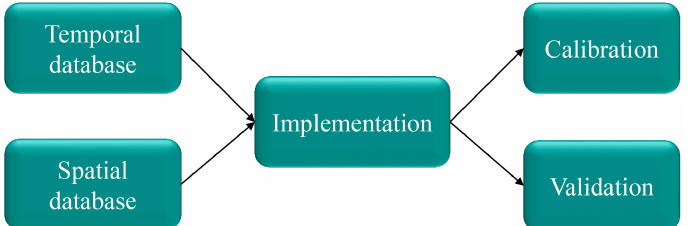
Figure 3. Representation of database implementation in a hydrological